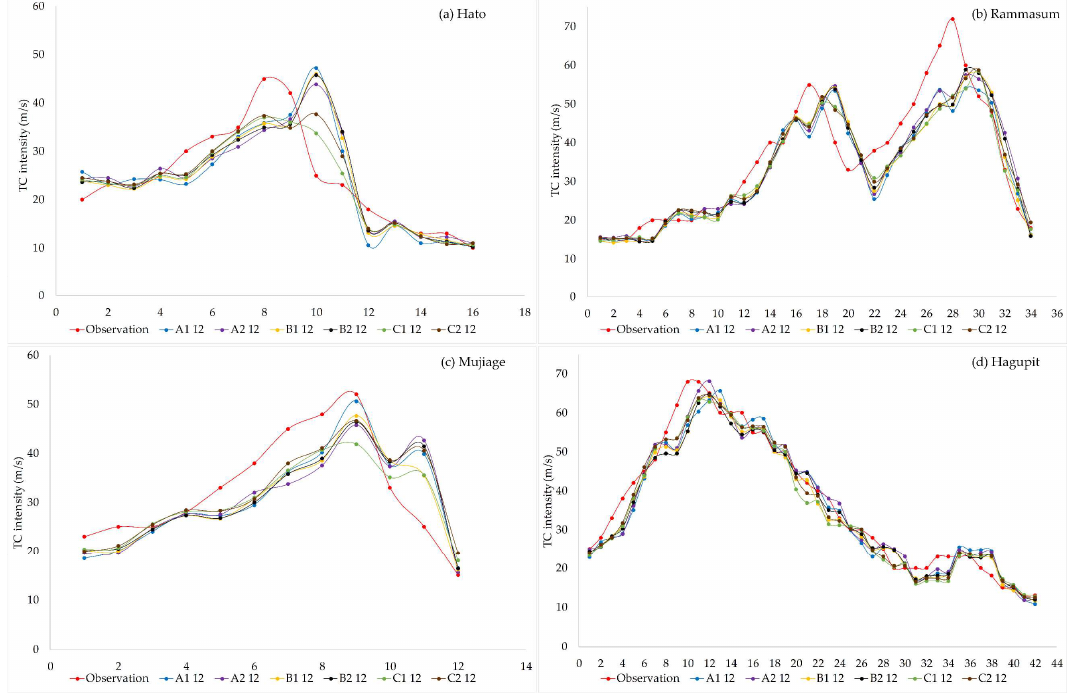
Figure 5. Observed and predicted sequence values of TC intensity with a 12 h lead time for ( a ) Hato, ( b ) Rammasum, ( c ) Mujiage, and ( d ) Hagupit, respectively. The following color coding is used: red (observation), blue (A1, 12 h lead time), purple (A2, 12 h lead time), orange (B1, 12 h lead time), black (B2, 12 h lead time), green (C1, 12 h lead time), and brown (C2, 12 h lead time). Atmosphere 2019 , 10 , x FOR PEER REVIEW 14 of 21